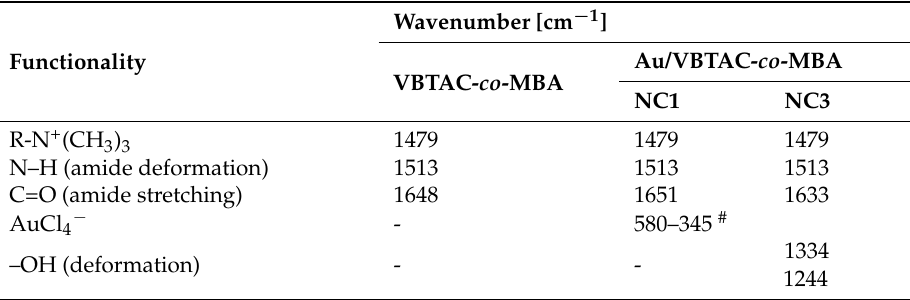
Table 1. Summarized FT-IR data for synthesized